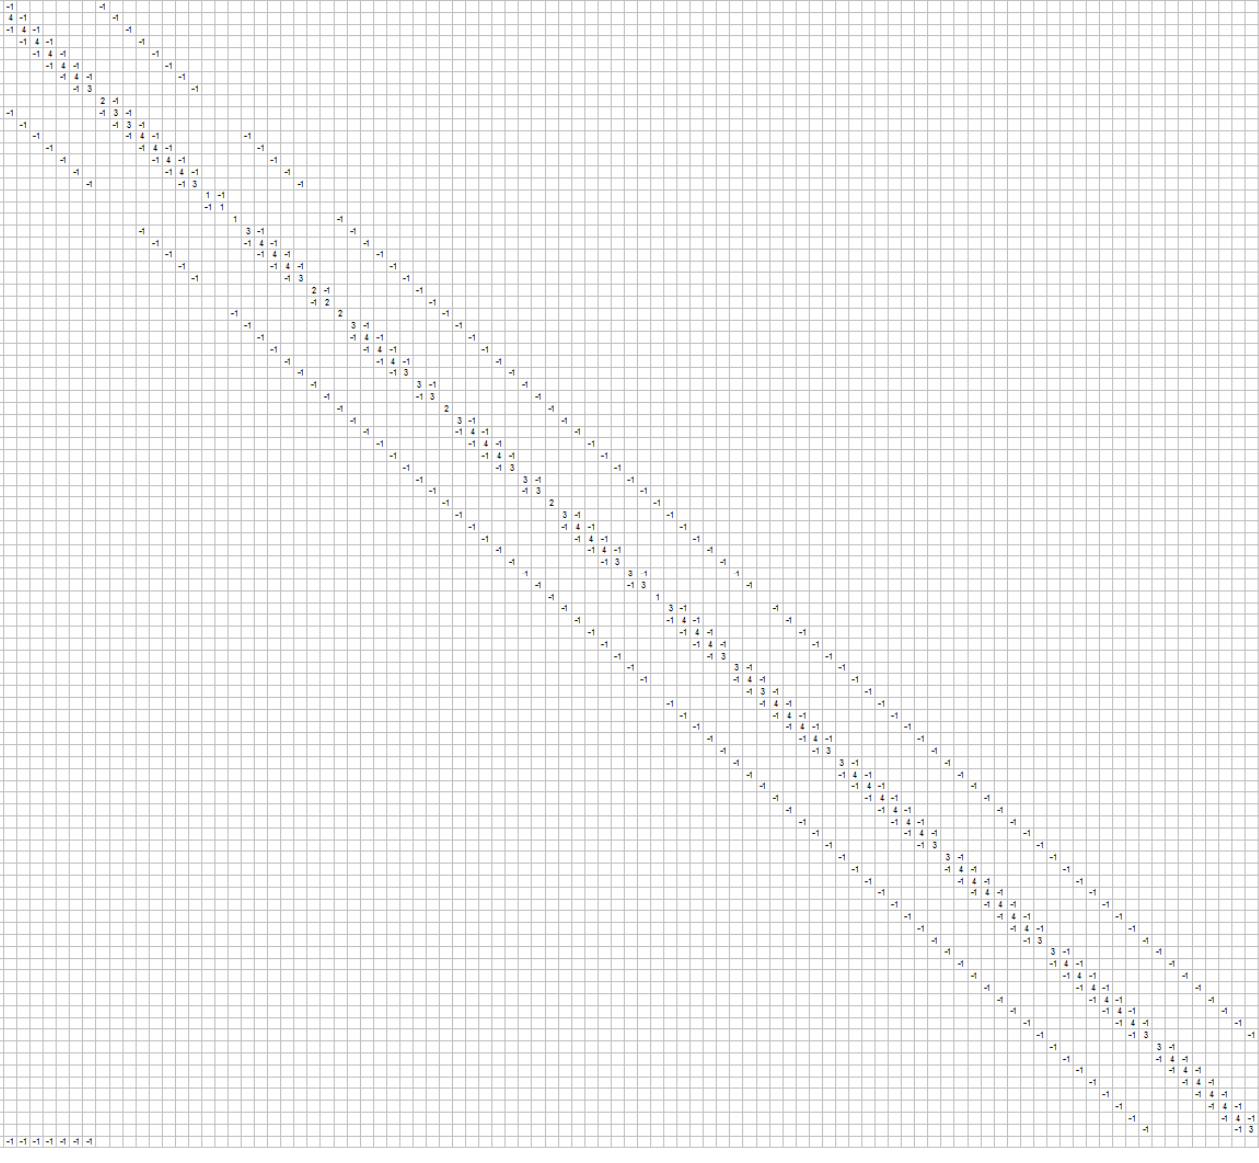
Figure A1. The system matrix for the example given in Section 3.